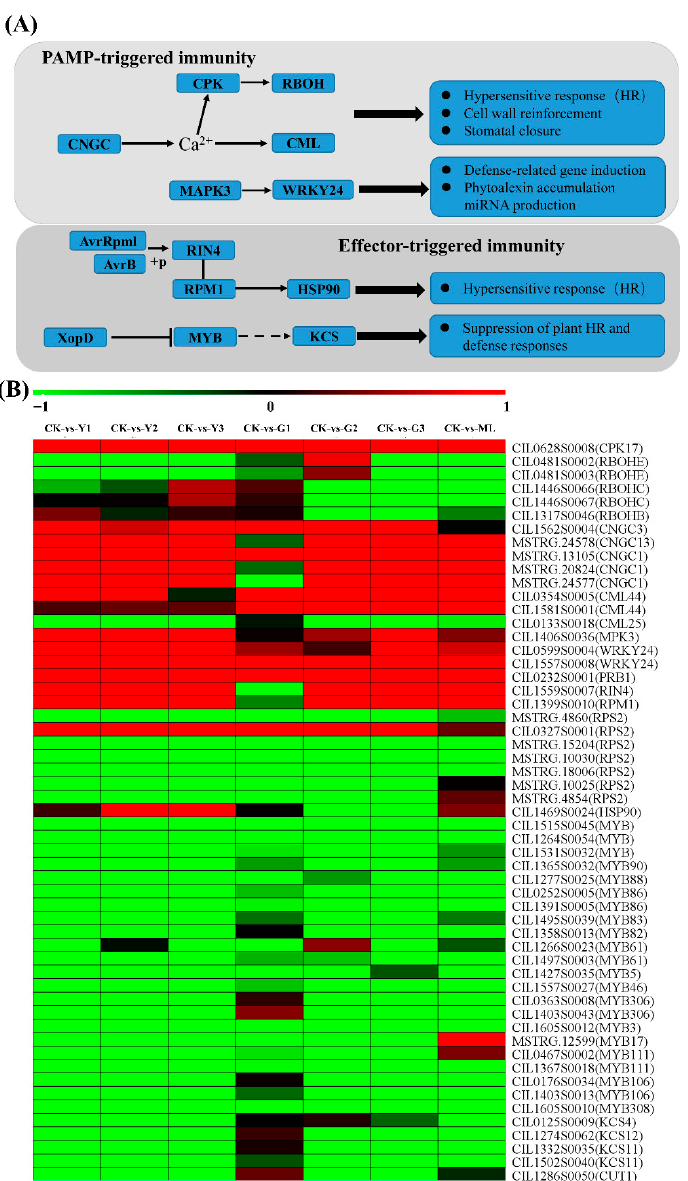
Figure 5. Inferred pecan-PMV interaction pathway using KEGG ortholog terms ( A ) and heat map of DEGs ( B ). Responsive progression of gene expression under different samples infected PMV compared to CK. Heat maps were drawn using the Log2 ratio (transformed FPKM value of PMV infection/those of CK). Detailed genes and expressions data were provided in Table S12, available as Supplementary Data online. CNGC, cyclic nucleotide-gated channel; CPK, calcium-dependent protein kinase; CML, calcium-binding protein; MPK3, mitogen-activated protein kinase 3; WRKY24, WRKY transcription factor 24; RBOH, respiratory burst oxidase homolog protein; PR1,